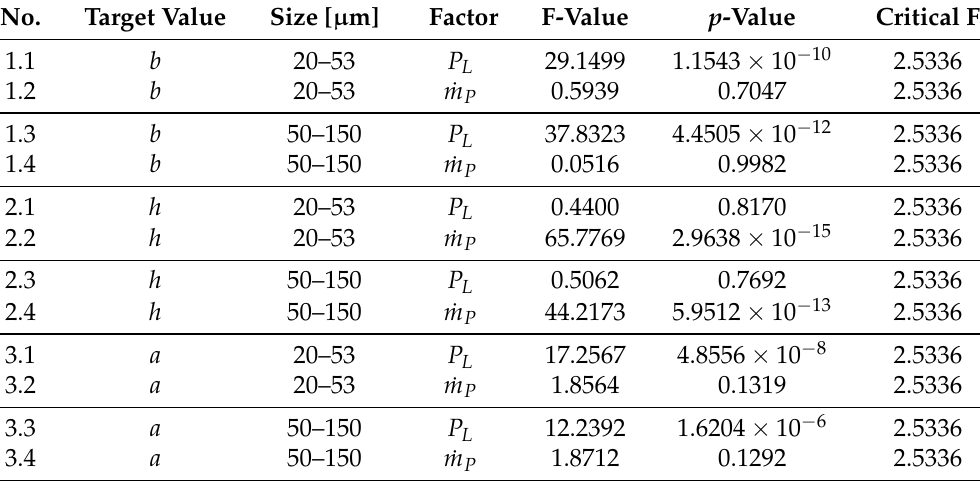
Table A7. Overview of the results of analysis of variance for varying laser power and mass flow.